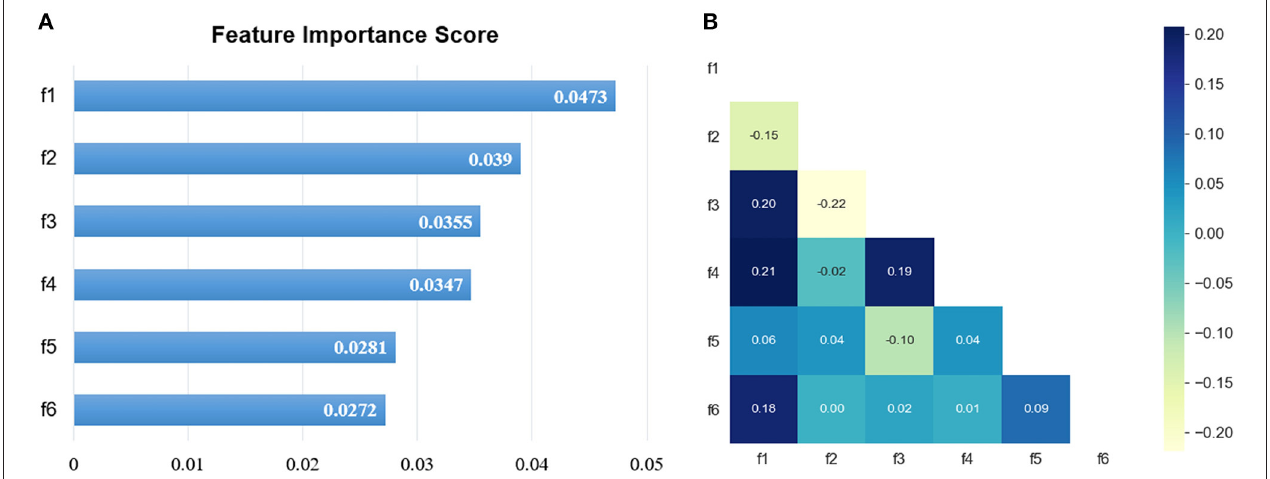
FIGURE 2 | The selected lung window features. (A) The RSF-based feature importance score; (B) the correlation heatmap.